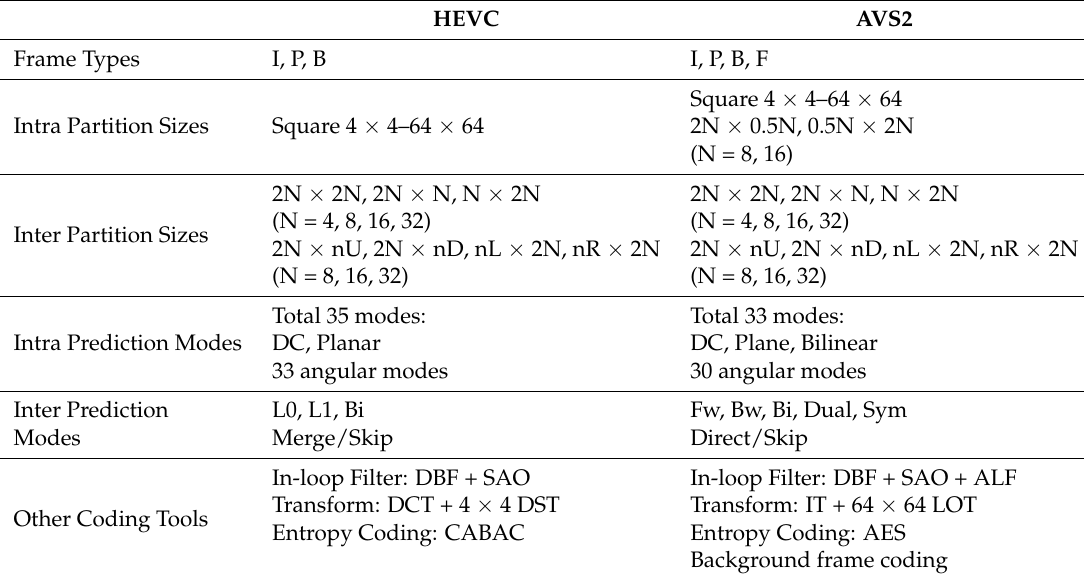
Table 1. Comparisons on Coding Tools between High Efficiency Video Coding (HEVC) and Audio and Video coding Standard